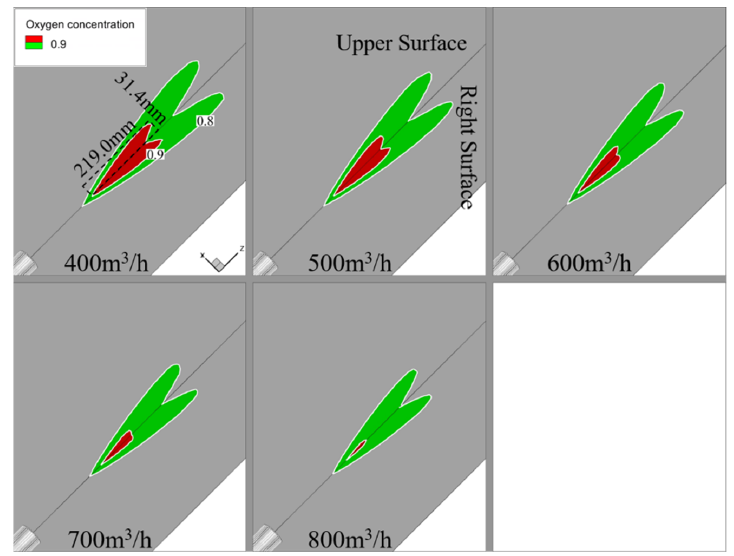
Figure 8. Oxygen concentration distribution of the casting slab surface.